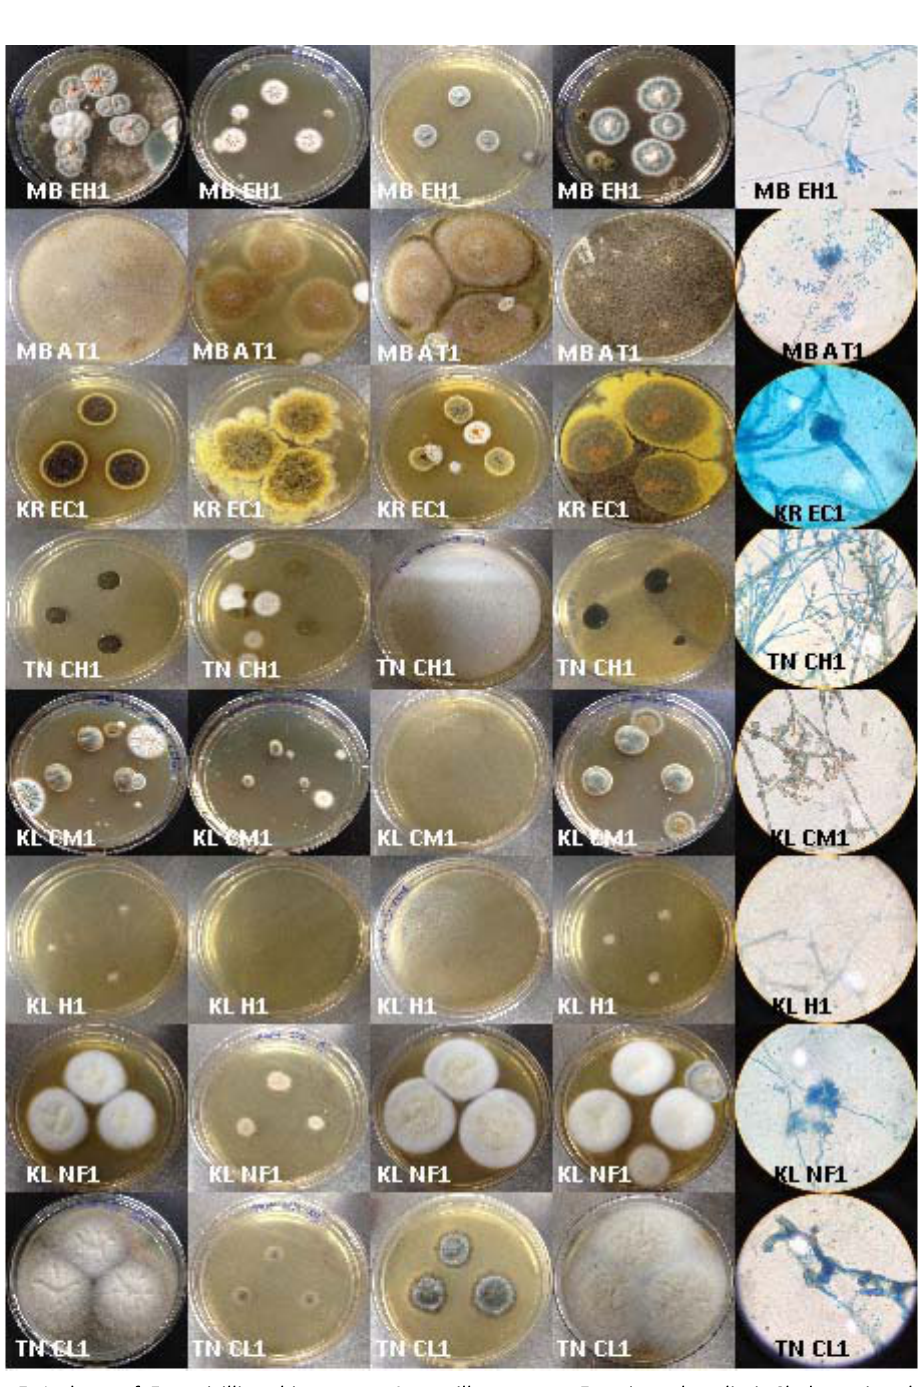
Fig. 5. Isolates of Eupenicillium hirayamae , Aspergillus terreus , Eurotium chevalieri , Cladosporium herbarum , Cladosporium macrocarpum , Hyphopichia sp., Neosartorya fischeri and Curvularia lunata grown on CYA 25°C, G25N 25°C, CYA 37°C, CY20S 25°C and microscopic